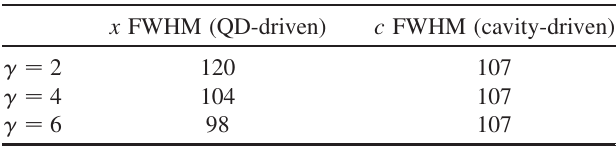
TABLE I. Dependence on the x=c FWHM of the intensity PL on (cid:7) , for a QD-driven cavity-measured PL ( x FWHM, ¼ 3 meV ), and for a cavity-driven QD-measured PL with (cid:1) cx ¼ 0 : 5 meV ). The QD-cavity parameters are ( c FWHM, with (cid:1) cx ¼ 30 (cid:8) eV , and (cid:7) 0 ¼ 2 (cid:8) (cid:10) ¼ 50 (cid:8) eV , g ¼ 20 (cid:8) eV , (cid:4) ð x=c Þ